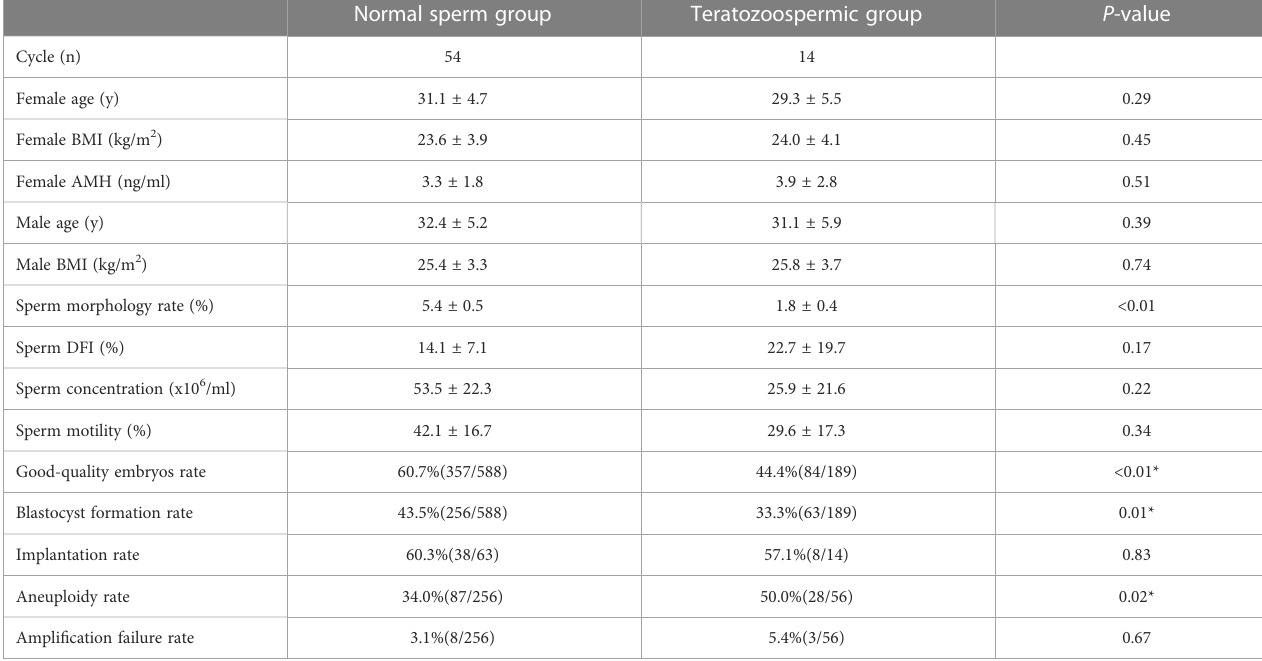
TABLE 1 Comparison of parameters between different sperm morphology